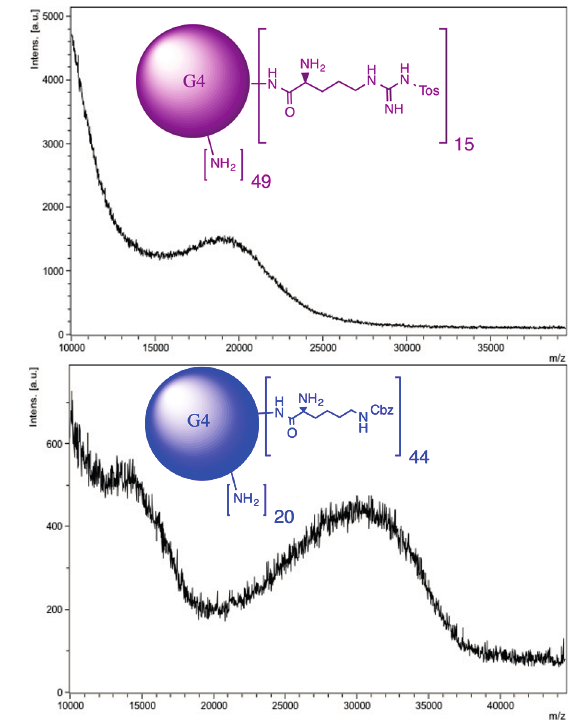
Figure 1. MALDI-MS spectra of PAMAM derivatives G4-(Arg-Tos) 15 and G4-(Lys-Cbz) 44